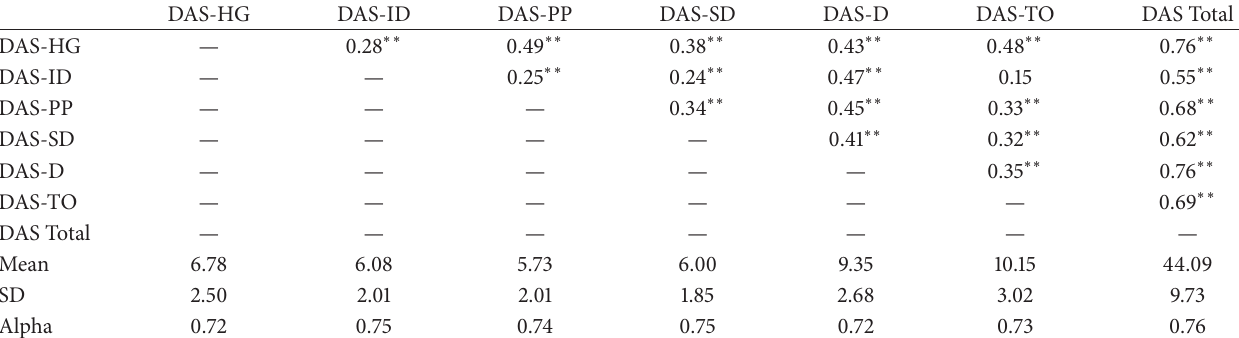
Table 3: Intercorrelations, means, standard deviations, and reliabilities for Driving Anger